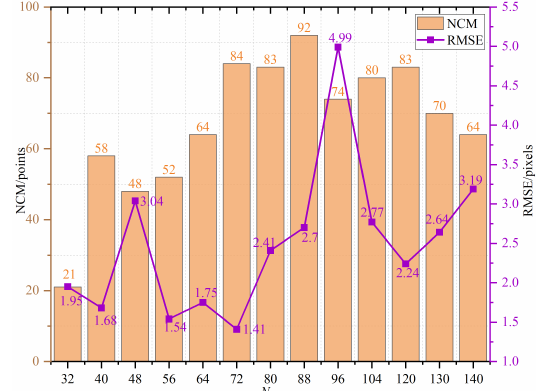
Figure 6. Results of different neighborhood windows.